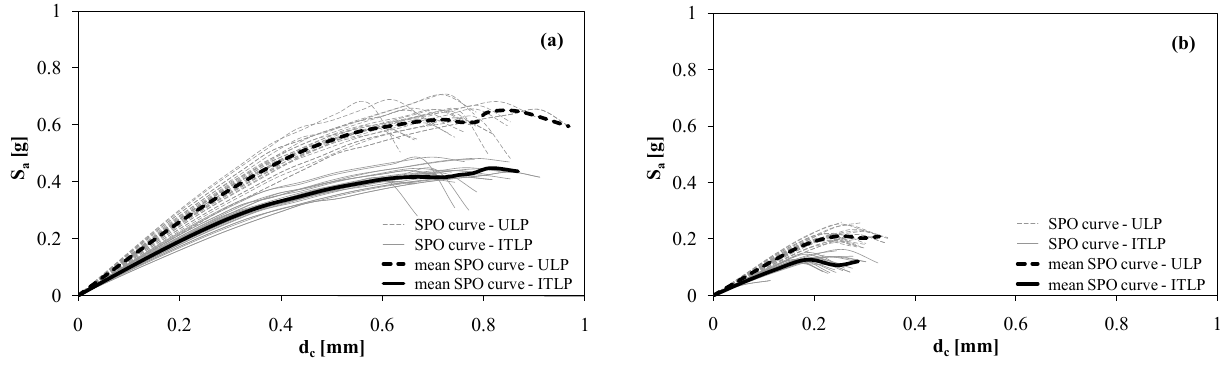
Figure 5. Static pushover (SPO) curves and their means related to the analysis cases: ( a ) 1X; ( b ) 1Y.